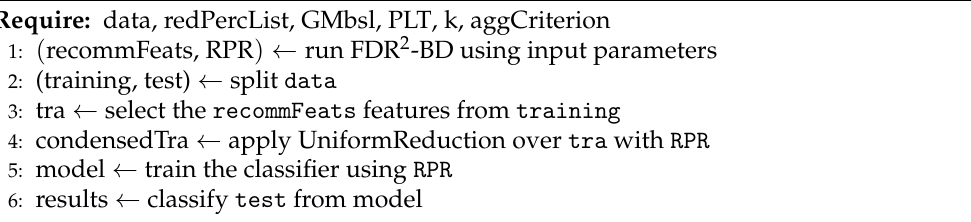
Algorithm 1 Pseudo-code showing the use of FDR 2 -BD for data reduction.